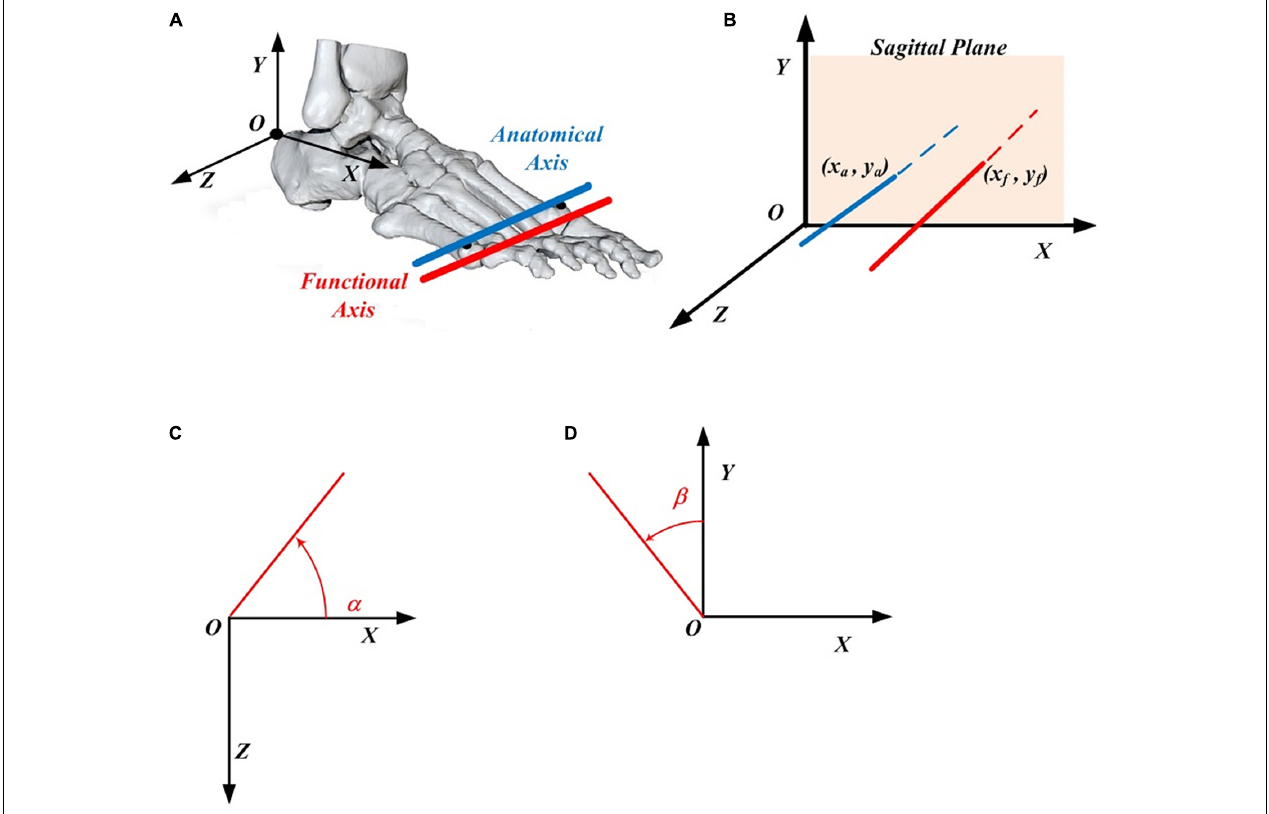
FIGURE 1 | Definition of the MP joint parameters. (A) The anatomical axis (blue) and functional axis (red) of the MP joint. (B) The position of the functional axis ( x f , y f ) and the anatomical axis ( x a , y a ) in the foot coordinate system. (C) Orientation angle α made by the functional (or anatomical) axis with respect to the X axis in the XOZ plane. (D) Orientation angle β made by the functional (or anatomical) axis with respect to the Y axis in the XOY plane.